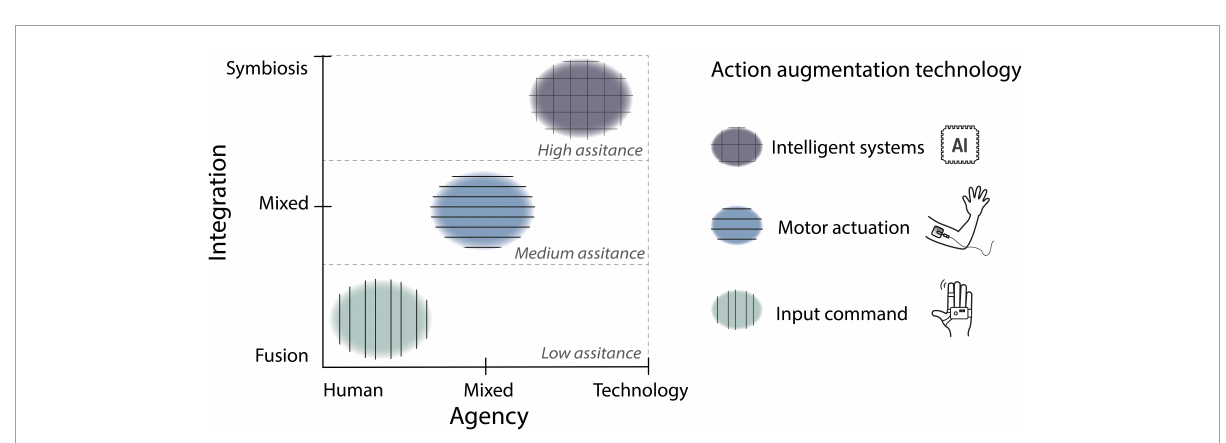
FIGURE10 Map of the three types of action augmentation technology that we identified (input command, motor actuation and intelligent systems) and their relationship with assistance level, agency, and integration.